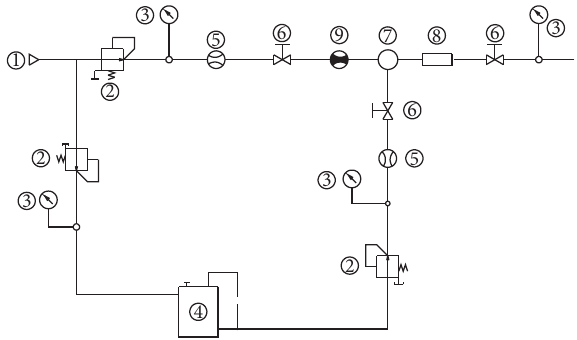
Figure 2: System schematic of foam device. 1, air compressor; 2, reducing valve; 3, pressure gage; 4, storage silo; 5, flowmeter; 6, stop valve; 7, air and liquid mixer; 8, foam generator; 9, air flow sensor.